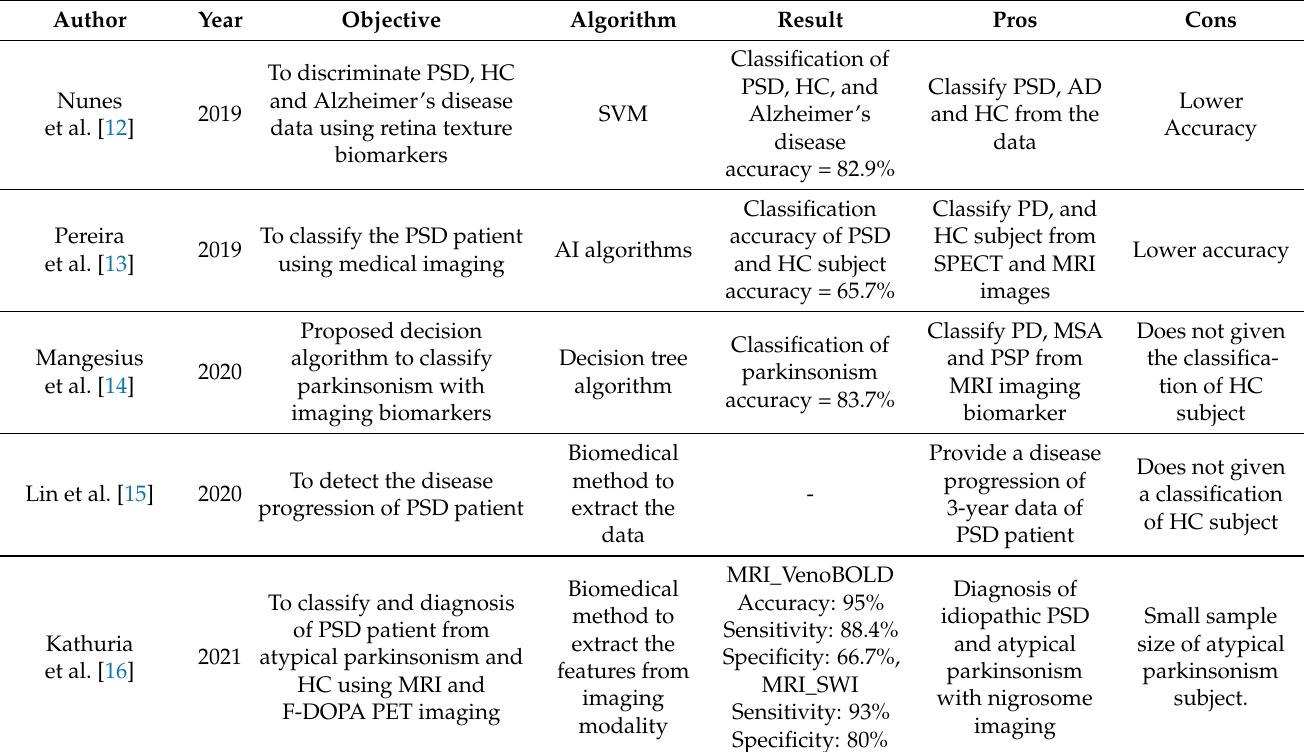
Table 1. Comparative analysis of the existing imaging biomarker-based schemes and the pro- posed